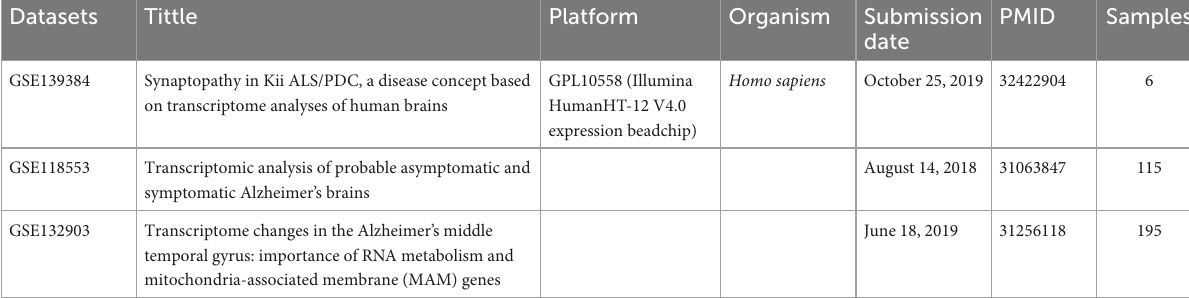
TABLE 1 Datasets characteristics.